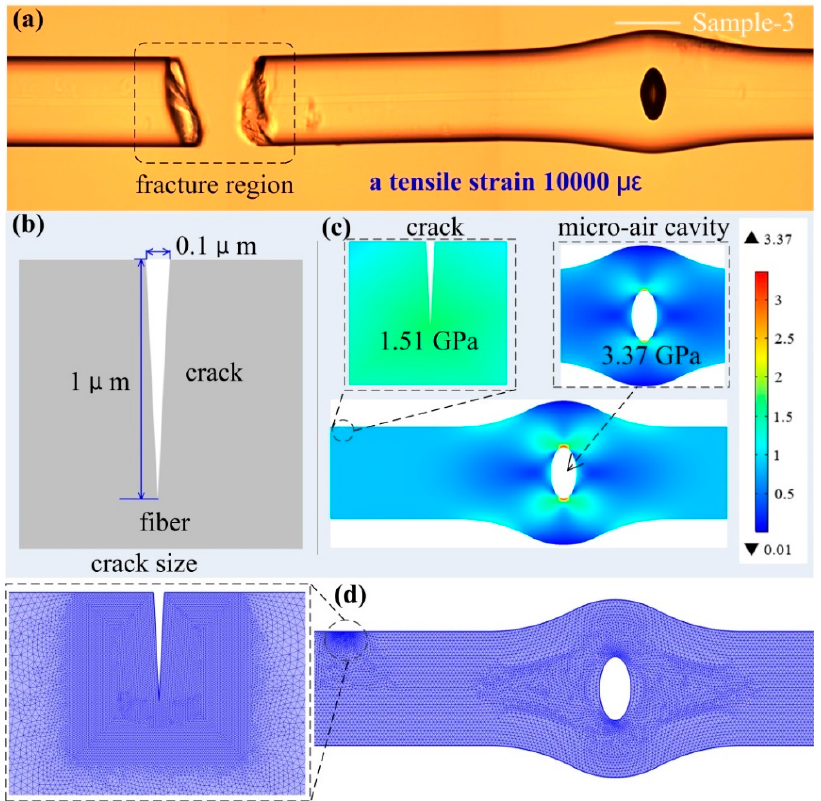
Figure 4. ( a ) Microscope images of the in-fiber FPI with fracture surface appears in the fiber. ( b ) Geometric model of crack in-fiber. ( c ) Two-dimensional stress contours while the axial strain of 10,000 µε applied to the model. ( d ) Mesh of the in-fiber FPI model.